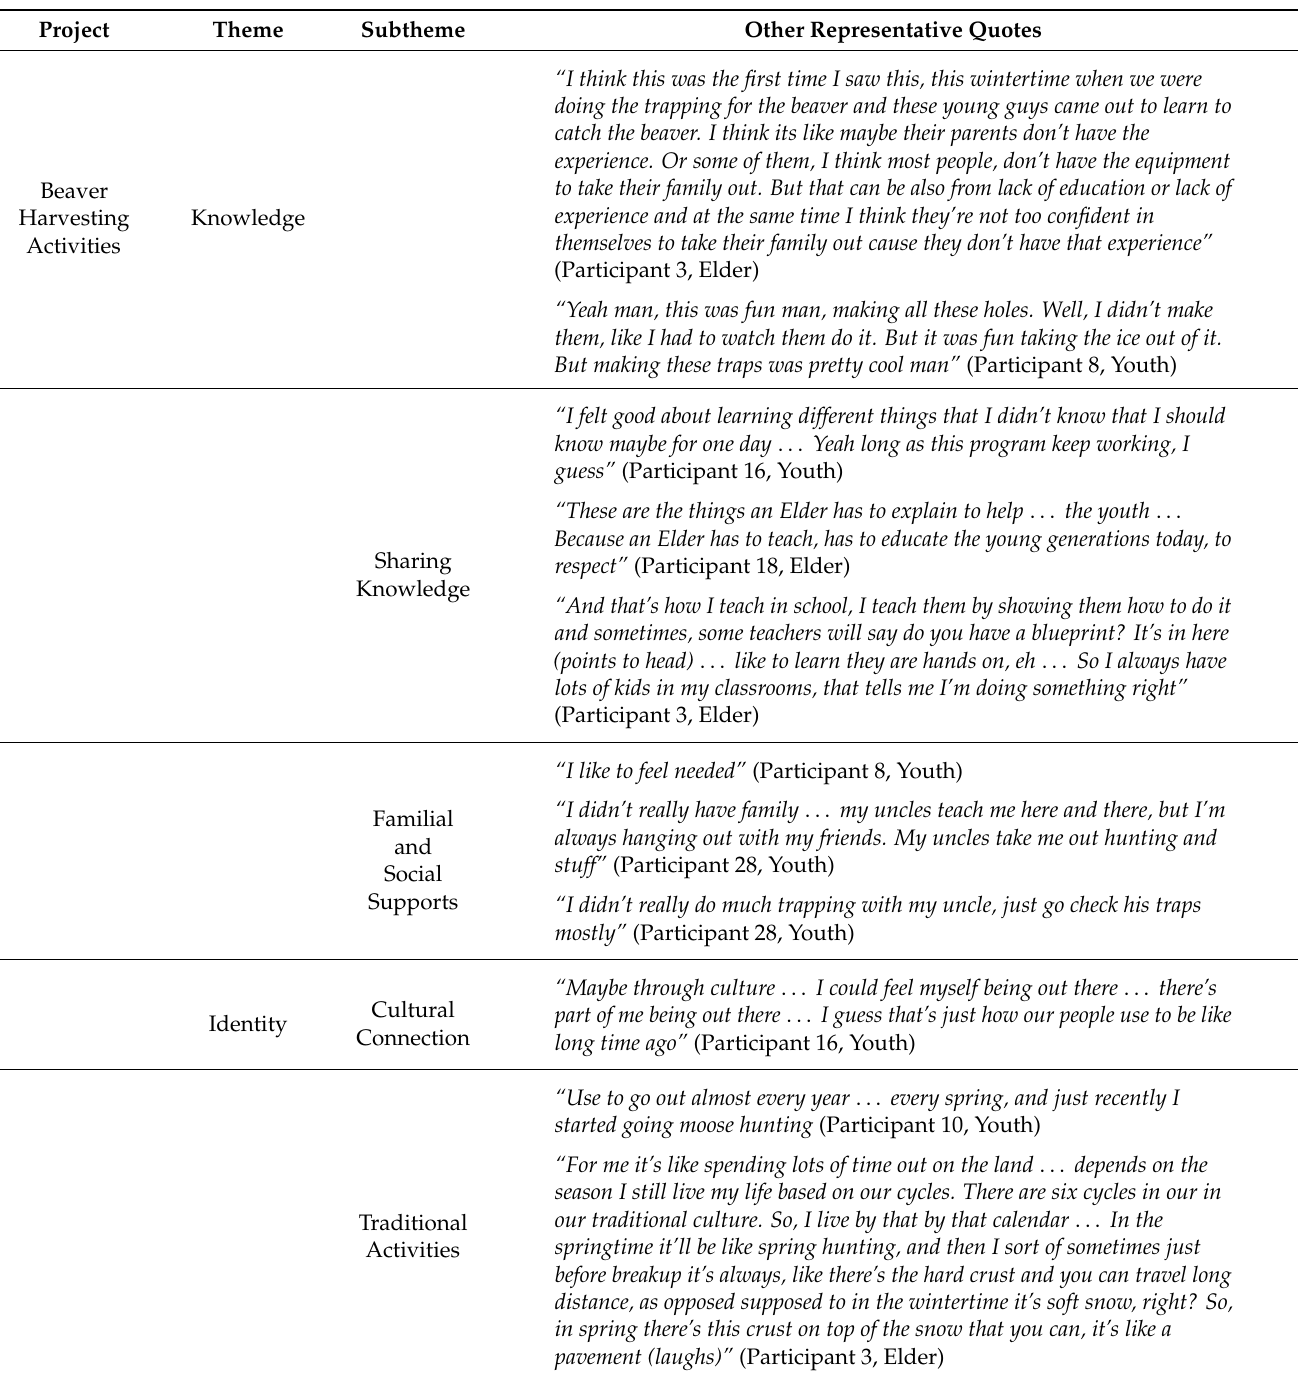
Table A1. The following quotations were not included in the primary text; however, they provide additional insight into the topic